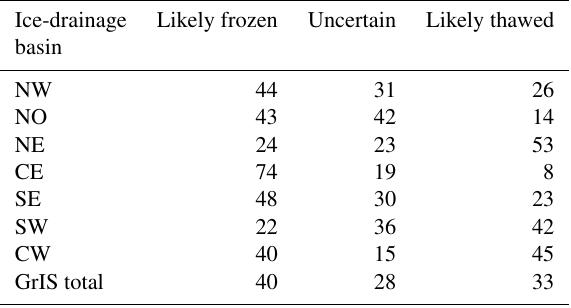
Table 4. Areal percentage of GBaTSv2 likely basal thermal state by Mouginot et al. (2019) ice-drainage basin ∗